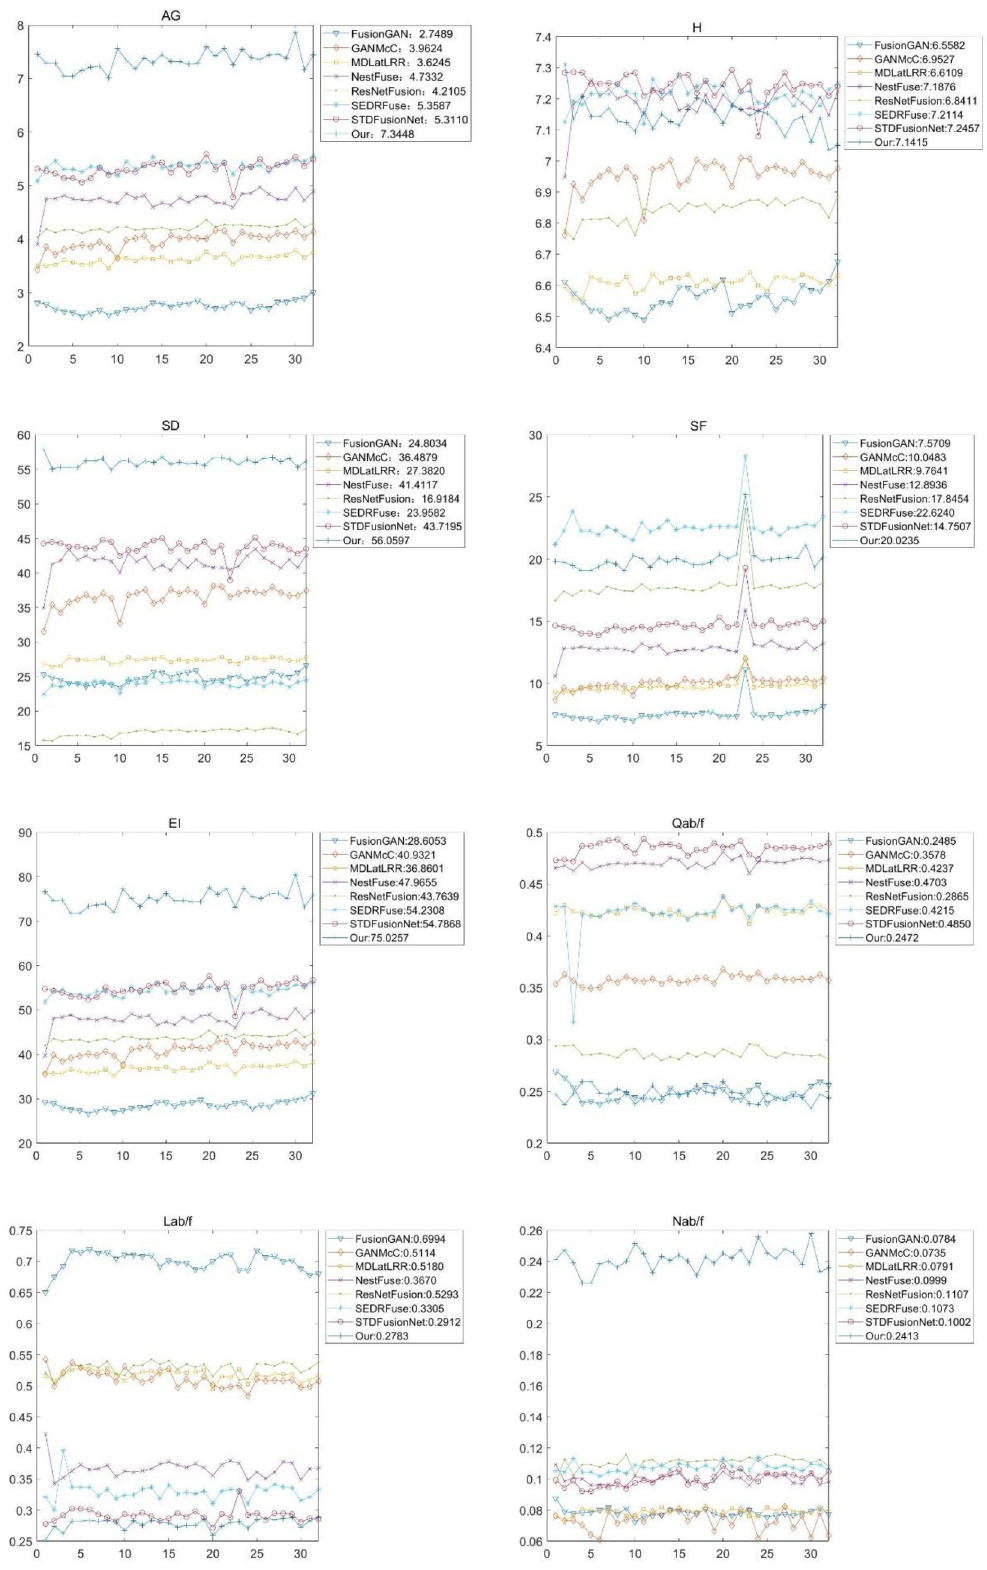
Fig 12. Quantitative comparisons in terms of the eight metrics; AG, H, SD, SF, EI, Q ab/f , L ab/f , and N ab/f , for the Nato_campsequence from the TNO dataset.